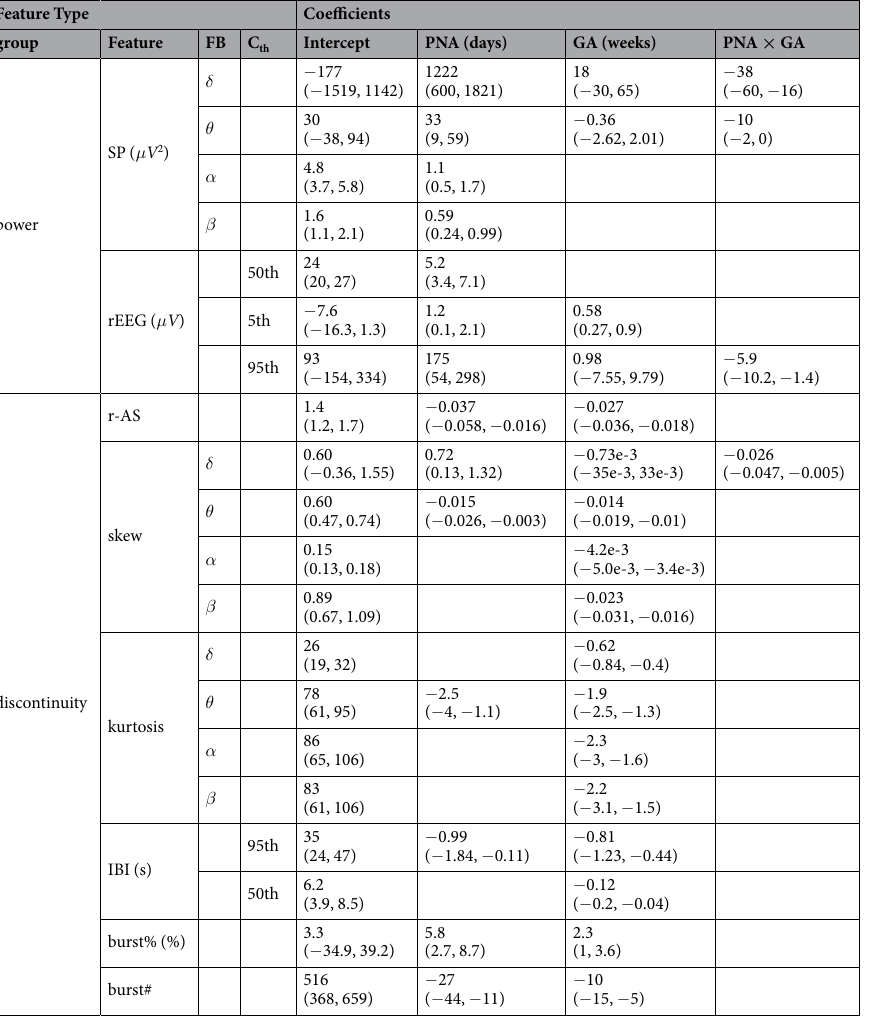
Table 2. Estimates (95% confidence intervals) of fixed-effect coefficients for EEG features in the power and discontinuity groups. Coefficients of the mixed-model include intercept, gestational age (GA, age at birth in weeks), postnatal age (PNA, time after birth in days), and the interaction term between PNA and GA (PNA × GA). Frequency bands (FB): 0.5–3 Hz ( δ ), 3–8 Hz ( θ ), 8–15 Hz ( α ), and 15–30 Hz ( β ); C th : centile. rEEG features (median, lower- and upper-margins) are described by corresponding centiles (50th, 5th, and 95th), as is median and maximum inter-burst intervals (50th and 95th centile). SP: spectral power; rEEG: range EEG; r-AS: rEEG asymmetry; IBI: inter-burst interval; burst%: burst ratio; burst#: number of